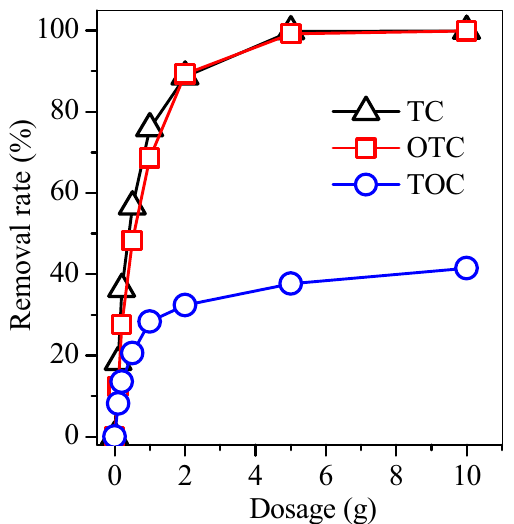
Figure 11. Dosage of Na500 on the treatment of pharmaceutical wastewater.